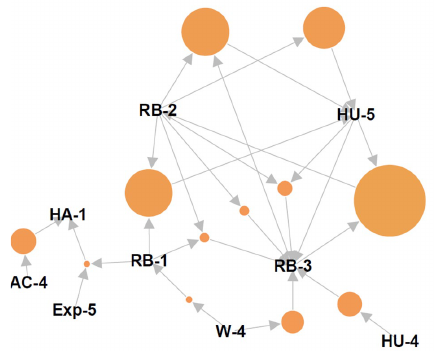
Figure 8. Network visualization of 12 rules filtered by lift defined values Table 3. Textual expression of rules obtained by